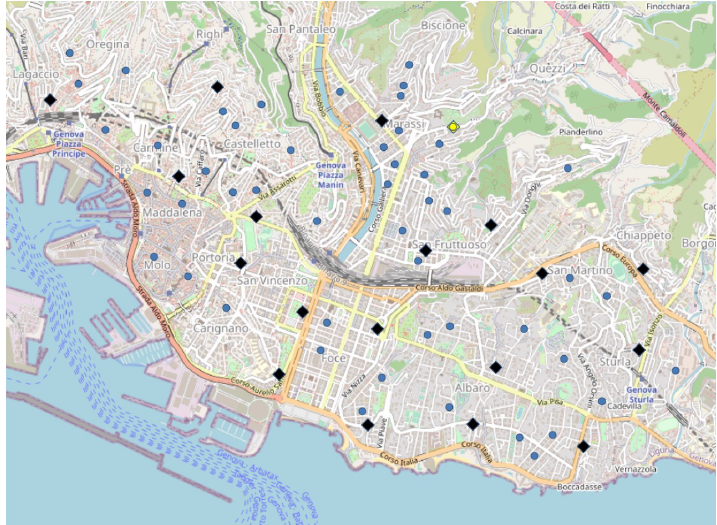
Figure 5. Urban area of the case study with the location of customers and pds